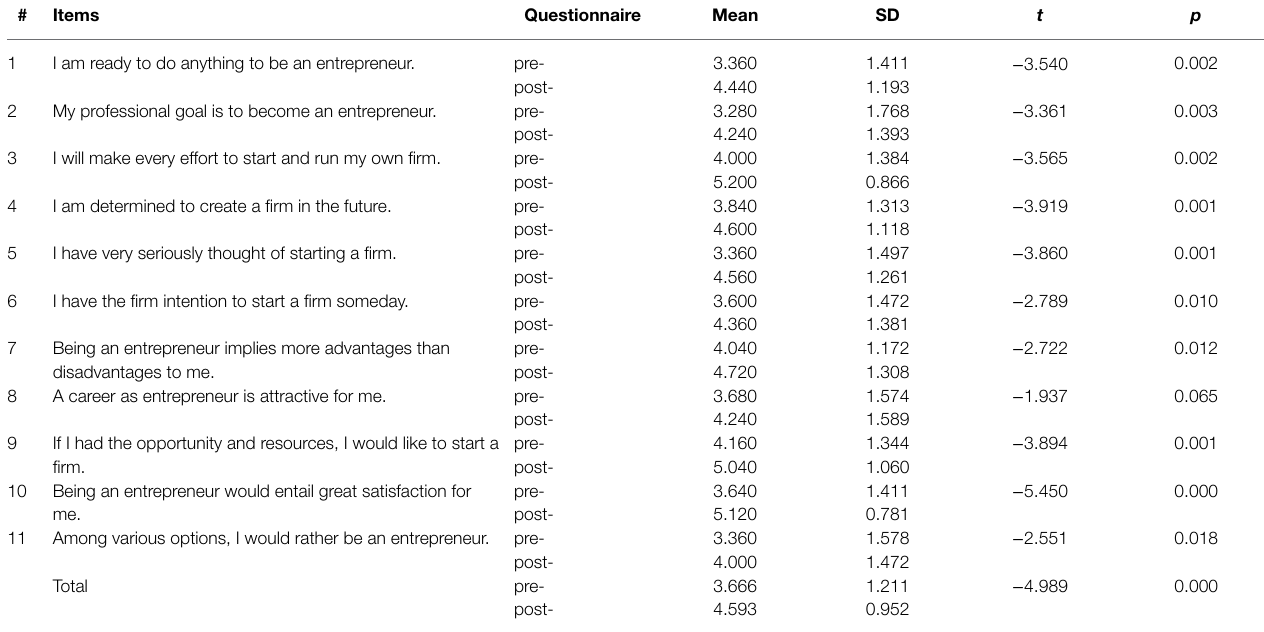
TABLE 3 | Perceived entrepreneurship before and after learning